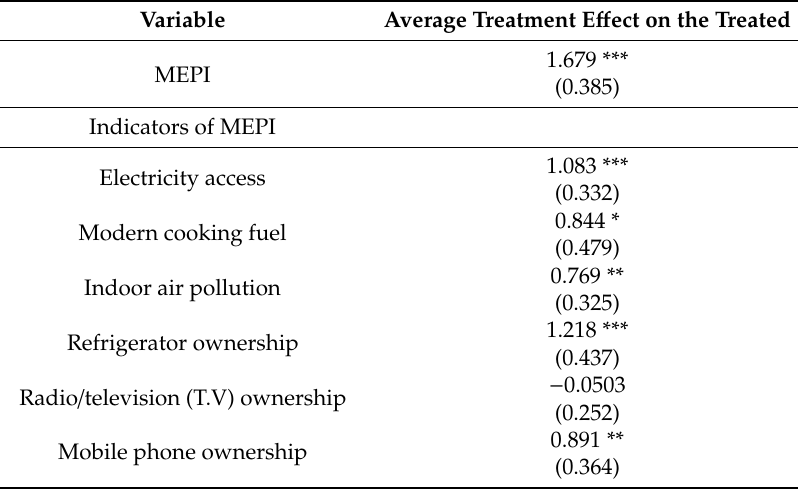
Table 6. PSM results of the e ff ect of MEPI and its indicators on